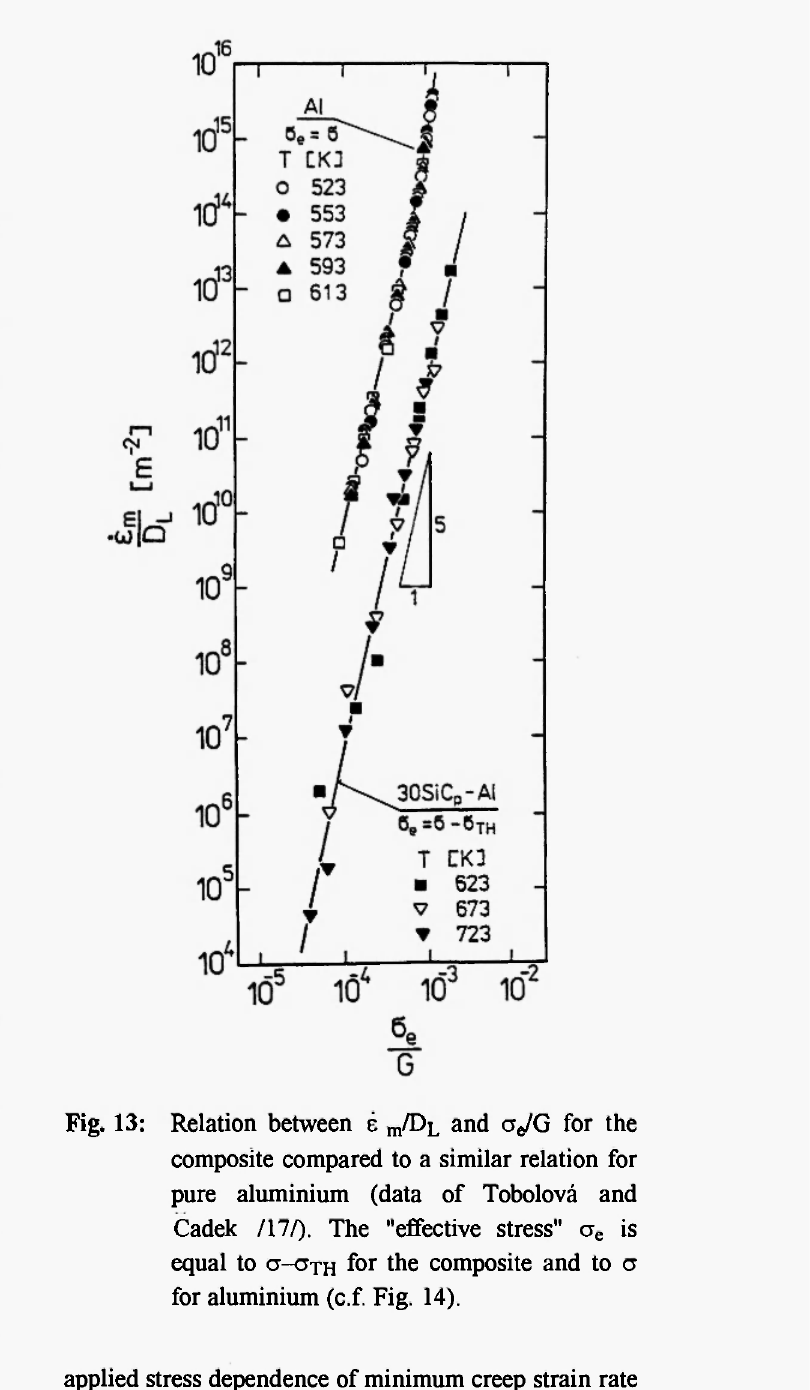
Fig. 13: Relation between έ composite compared to a similar relation for pure aluminium (data of Tobolovä and Cadek